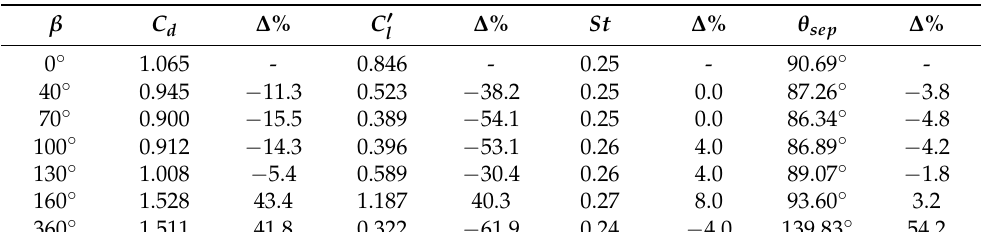
Table 2. Comparison of the results for the varying partial porous coating angles, the fully coated cylinder ( β = 360 ◦ ) and the smooth cylinder ( β = 0 ◦ ).